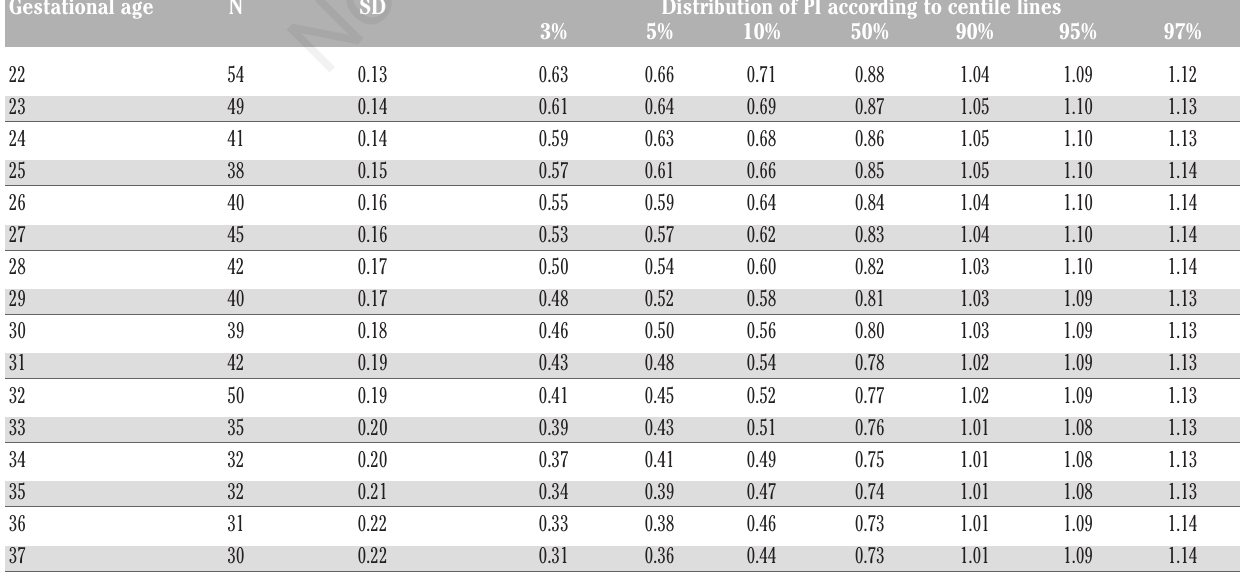
Table 2. PI values corresponding to centile lines 3, 5, 10, 50, 90, 95, 97 for 22-37 weeks of gestational age. Gestational